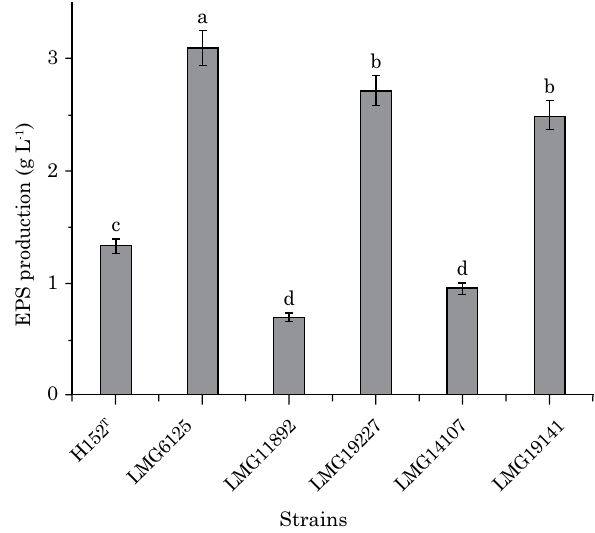
figure 1. evaluation of the differences in exopolysaccharide production by Rhizobium giardini bv. giardini h152 t , Mesorhizobium loti lMG6125, Mesorhizobium plurifarium lMG11892, Sinorhizobium (= Ensifer ) kostiense lMG19227, Mesorhizobium huakuii lMG14107, and Rhizobium mongolense lMG19141. bars on columns indicate standard error. bars labeled with identical letters are not significantly different